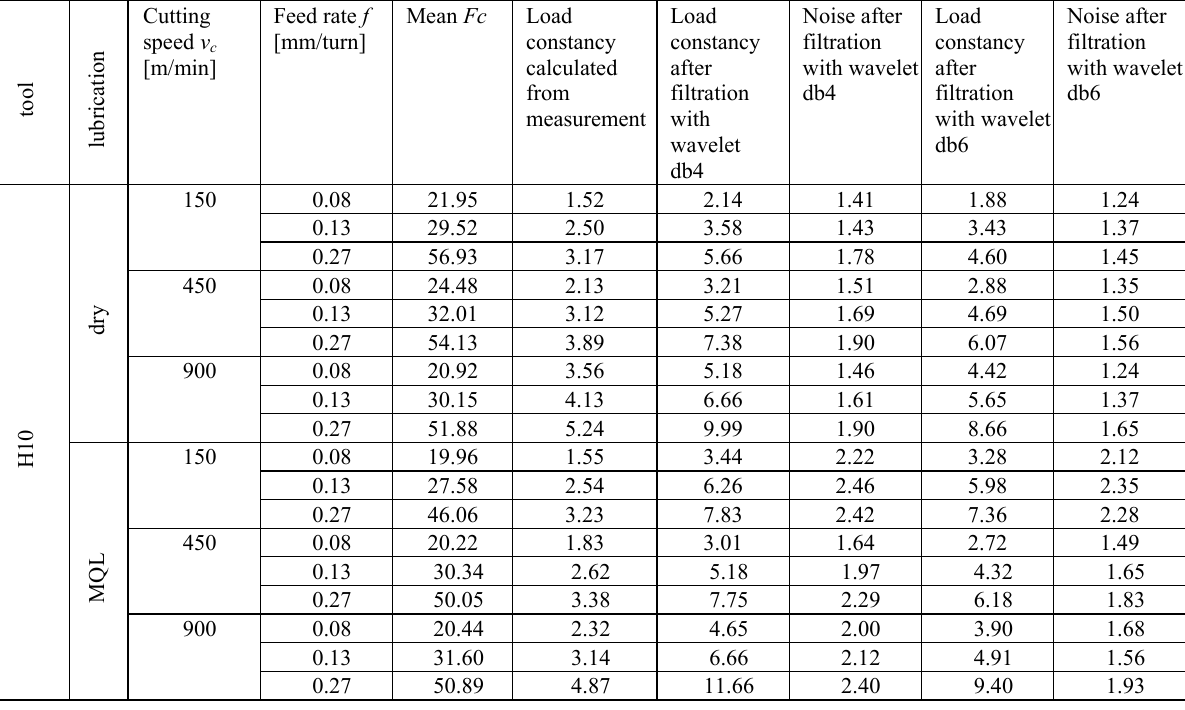
Table 4. Measured cutting forces Fc, measurement-based load constancy factor values and after filtration with wavelets and noise values for aluminium composite turning with uncoated carbide tool.